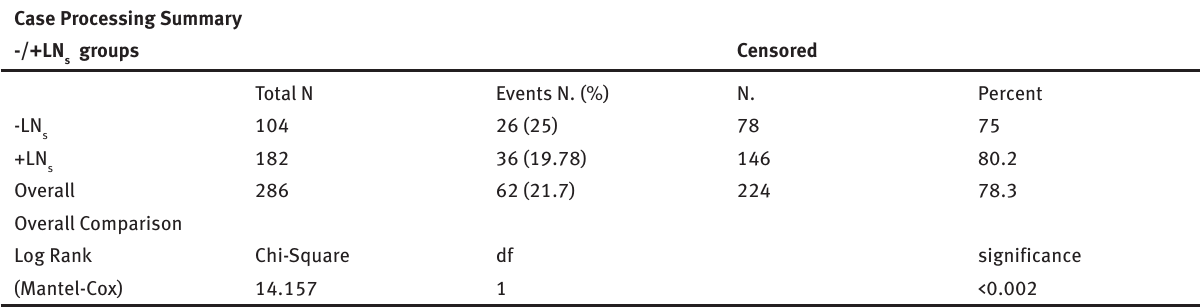
Table 3: Disease Free Survival between -LN group and +LN (survival rate: 75% vs 80.2%, respectively; p < .002). Case Processing Summary -/+LN s